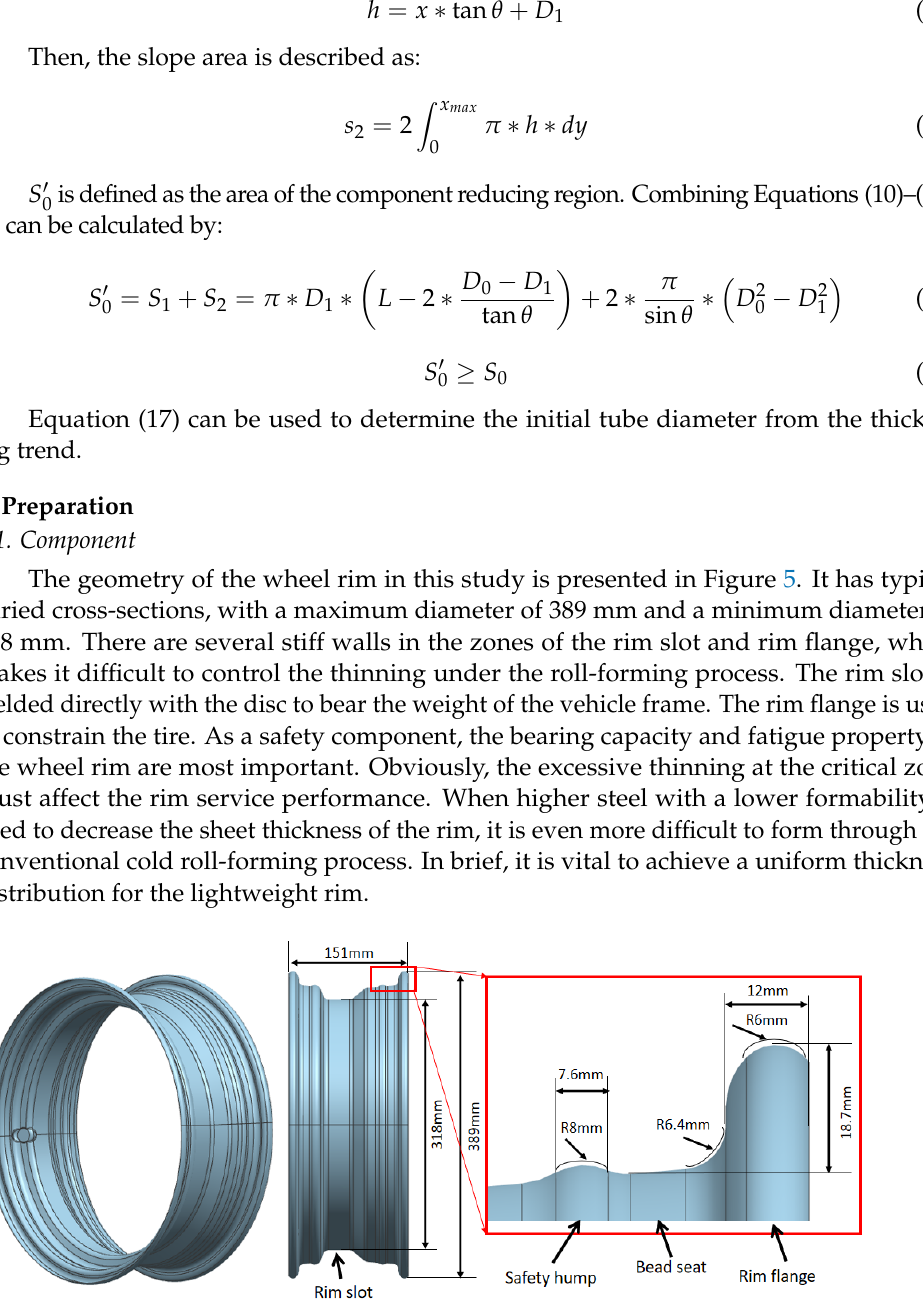
Figure 5. The 3D model of the wheel rim.